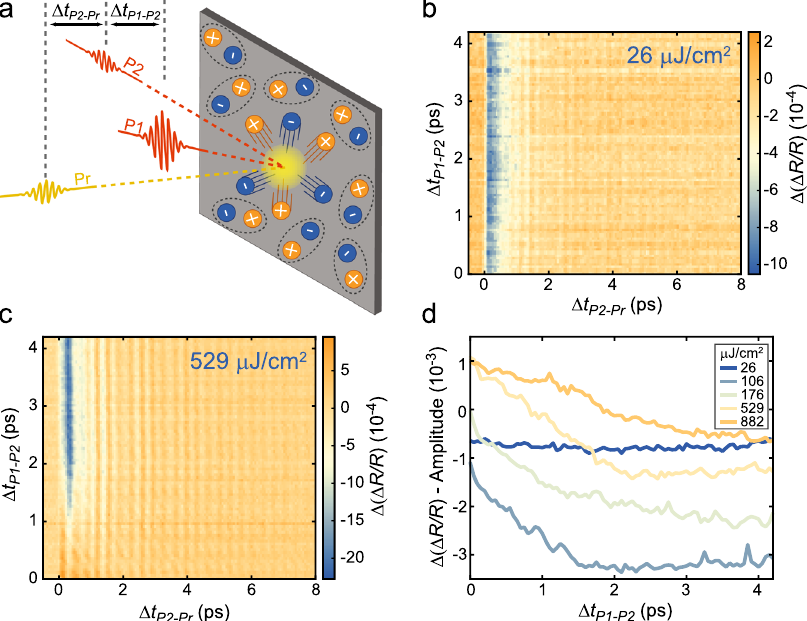
Fig. 3 Recovery of the EI phase measured with multi-pulse ultrafast spectroscopy. a Schematic of the multi-pulse experiment. b , c Δ ( Δ R / R ) signal at 1200 nm as a function of the P2 – Pr and P1 – P2 delays for Φ P1 = 26 µ J/cm 2 ( b ) and Φ P1 = 529 µ J/cm 2 ( c ). d Evolution of the Δ ( Δ R / R ) amplitude as a function of the P1 – P2 delay for different values of Φ P1